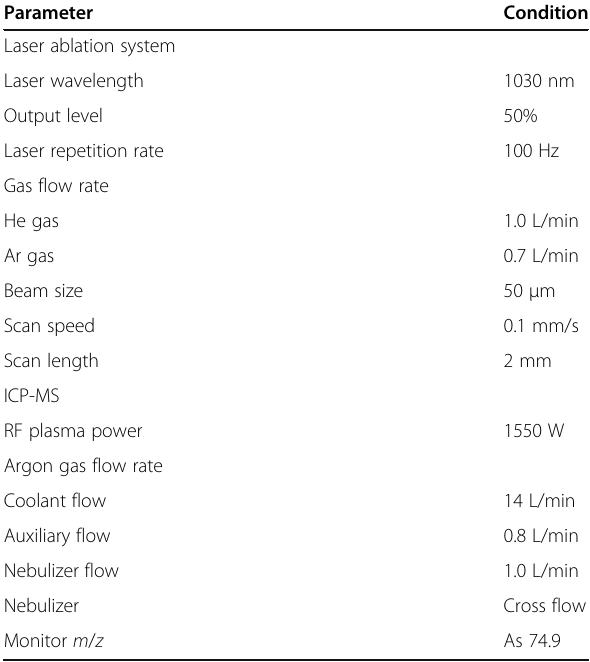
Table 1 Operating parameters for fs